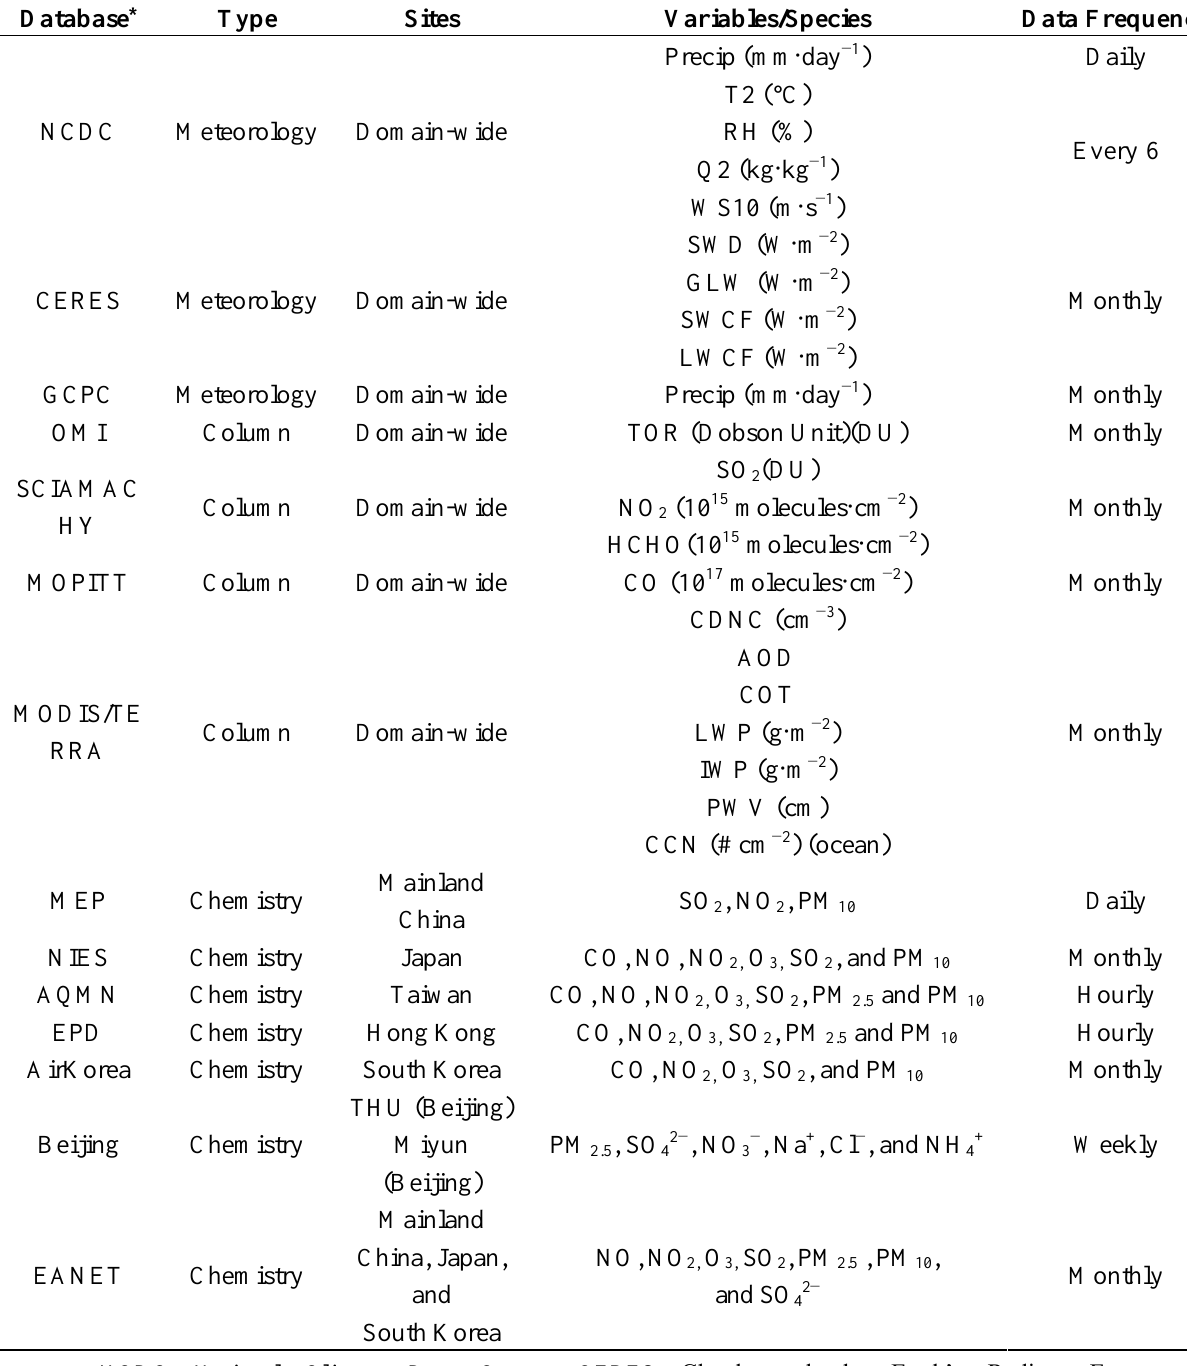
Table 2. Surface and satellite observations used in the model